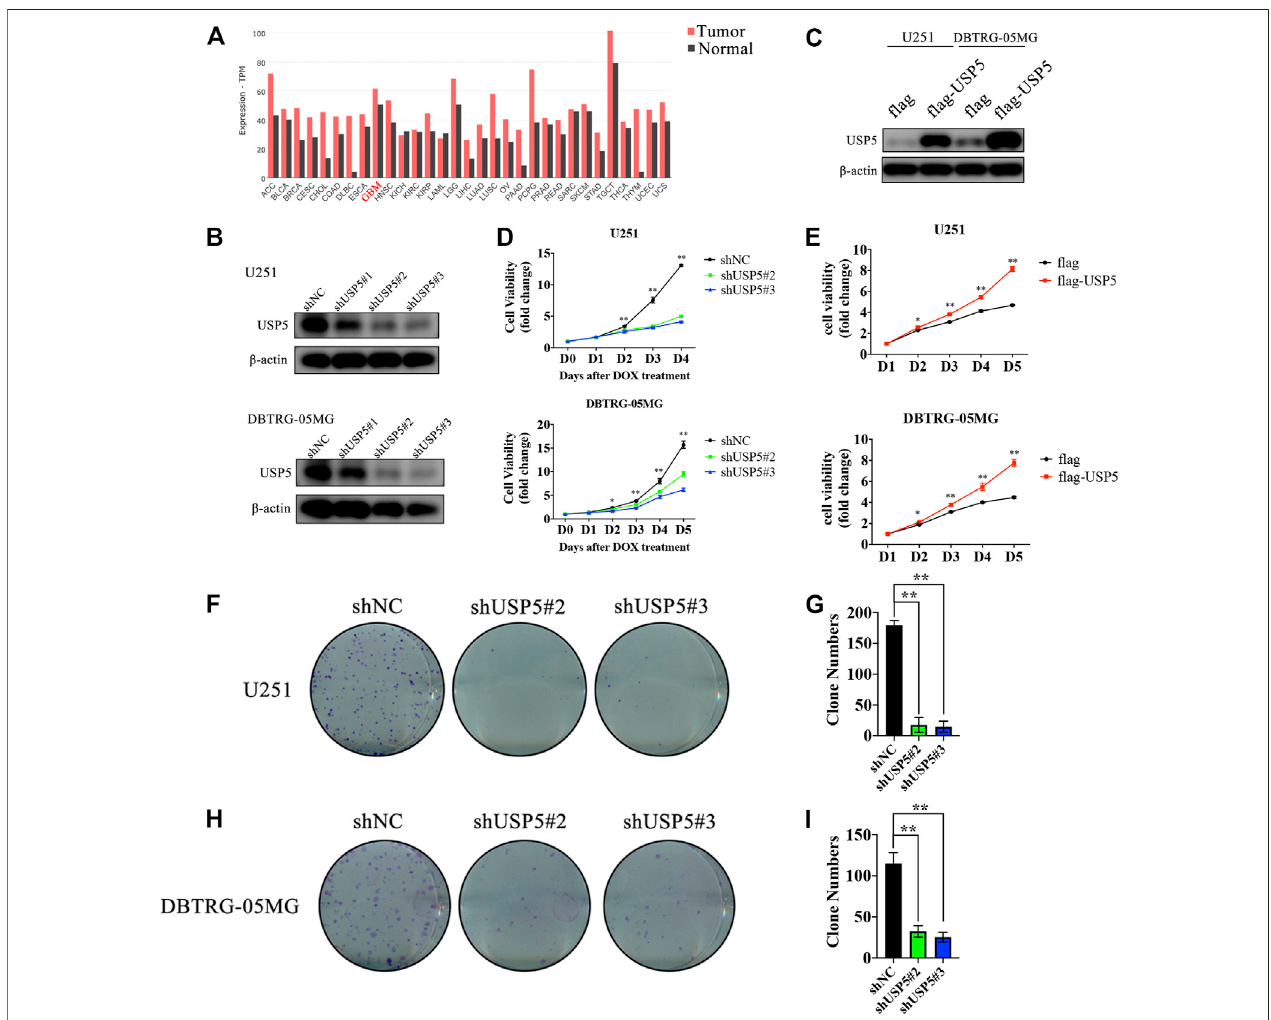
FIGURE 1 | USP5 was closely related with GBM cells proliferation (A) USP5 mRNA expression level in a broad range of tumors and relevant normal tissues (generatedfrom GEPIA2: http://gepia2.cancer-pku.cn) (B) U251and DNTRG-05MGcells wereinfected withUSP5 shRNAs (#1, #2, and #3) and control shRNA (shNC) by lentivirus, shRNA expression was induced by 2 ug/mL Doxycycline (DOX) treatment for 72 h. Western blotting analysis was performed to check the knockdown ef fi ciencyofUSP5shRNAs (C) U251andDNTRG-05MGcellswereinfectedwithUSP5overexpressionplasmidwith3 × fl agtag( fl ag-USP5)andemptyvector( fl ag) by lentivirus. Western blotting was performed to check the expression level of USP5 (D) Proliferation of U251 and DBTRG-05MG cells expressed shNC or shUSP5 (#2, #3) was detected by CCK-8 assay after DOX treatment at indicated time points (E) Proliferation of U251 and DBTRG-05MG cells expressed fl ag or fl ag-USP5